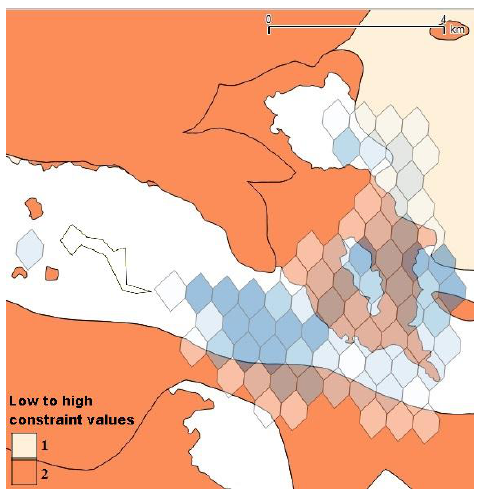
Figure 9. Dredge and trawling areas.